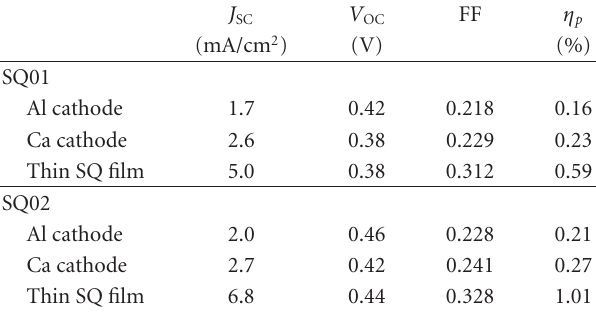
Table 1: Photovoltaic performance of SQ01- and SQ02-based solar cells using C 60 as electron acceptor. Film thicknesses of 40 nm and 35nm were used for SQ01 and SQ02, respectively. When ultrathin films were used, the thickness corresponds to 20nm for both squaraine derivatives. The type of cathode utilized in the devices is also indicated.